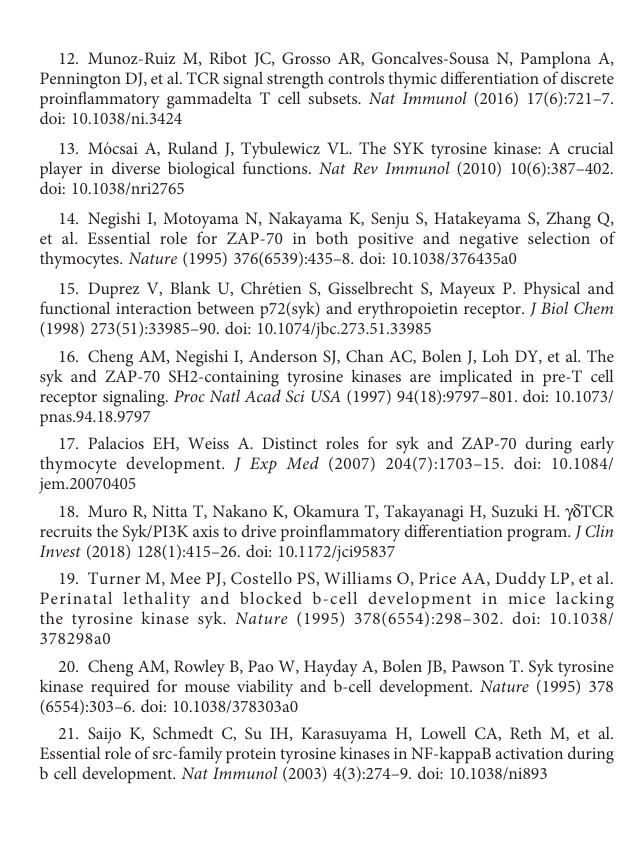
represent the mean ± SEM of four independent experiments. *P < 0.05 and **P < 0.01, by 1-way ANOVA. SUPPLEMENTARY FIGURE 3 Cell surface expression of CD3 e and TCR d in Syk-de fi cient thymic gd T cells. The mean fl uorescence intensity (MFI) of CD3 e and TCR d as gated in Figure 1E is shown. 4 to 6-week-old control mice (Cd127-cre Syk fl ox/wt, n = 6)or Syk-cKO mice (Cd127-cre Syk fl ox/ fl ox, n =7) wereused. All data represent the mean ± SEM of three independent experiments. *P < 0.05 and **P < 0.01, by unpaired t-test. SUPPLEMENTARY FIGURE 4 The frequency of gd T cell subsets in the thymus and peripheral tissues. Graphs show the frequency of V g 1 + , V g 4 + , V g 5V d 1 + , V g 6 + and V g 7 + gd T cells in the indicated tissues (n = 4 to 6). All data represent the mean ± SEM of three independent experiments. *P < 0.05 and **P < 0.01, by unpaired t-test. SUPPLEMENTARY FIGURE 5 ab T cells and B cells in IMQ-treated Syk-cKO mice. Representative fl ow cytometric pro fi les of B220 and TCR b expression in cervical lymph node (cLN) from IMQ- or Vaseline-treated mice as shown in . The graphs depict the number of CD4 + T cells (CD4 + TCR b + ), CD8 + T cells (CD4 + TCR b + ) andBcells(B220 + ).Vaseline-treated controlmice(Cd127-creSyk fl ox/wt, n= 6), IMQ-treated control (n = 7) and IMQ-treated Syk-cKO (Cd127-cre Syk fl ox/ fl ox n = 10) was used. All data represent the mean ± SEM of two independent experiments. *P < 0.05 and **P < 0.01, by 1-way ANOVA. SUPPLEMENTARY FIGURE 6 List of primers for quantitative PCR used in this